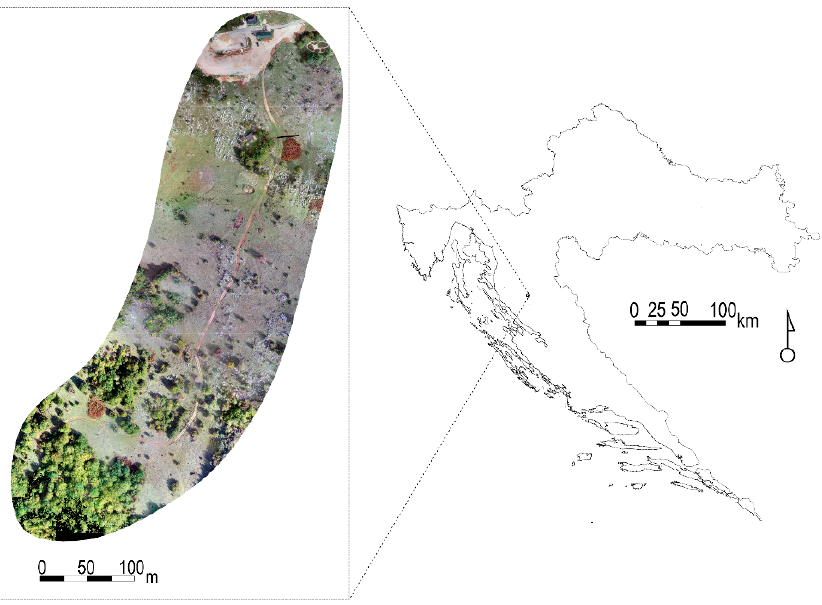
Figure 1. Research